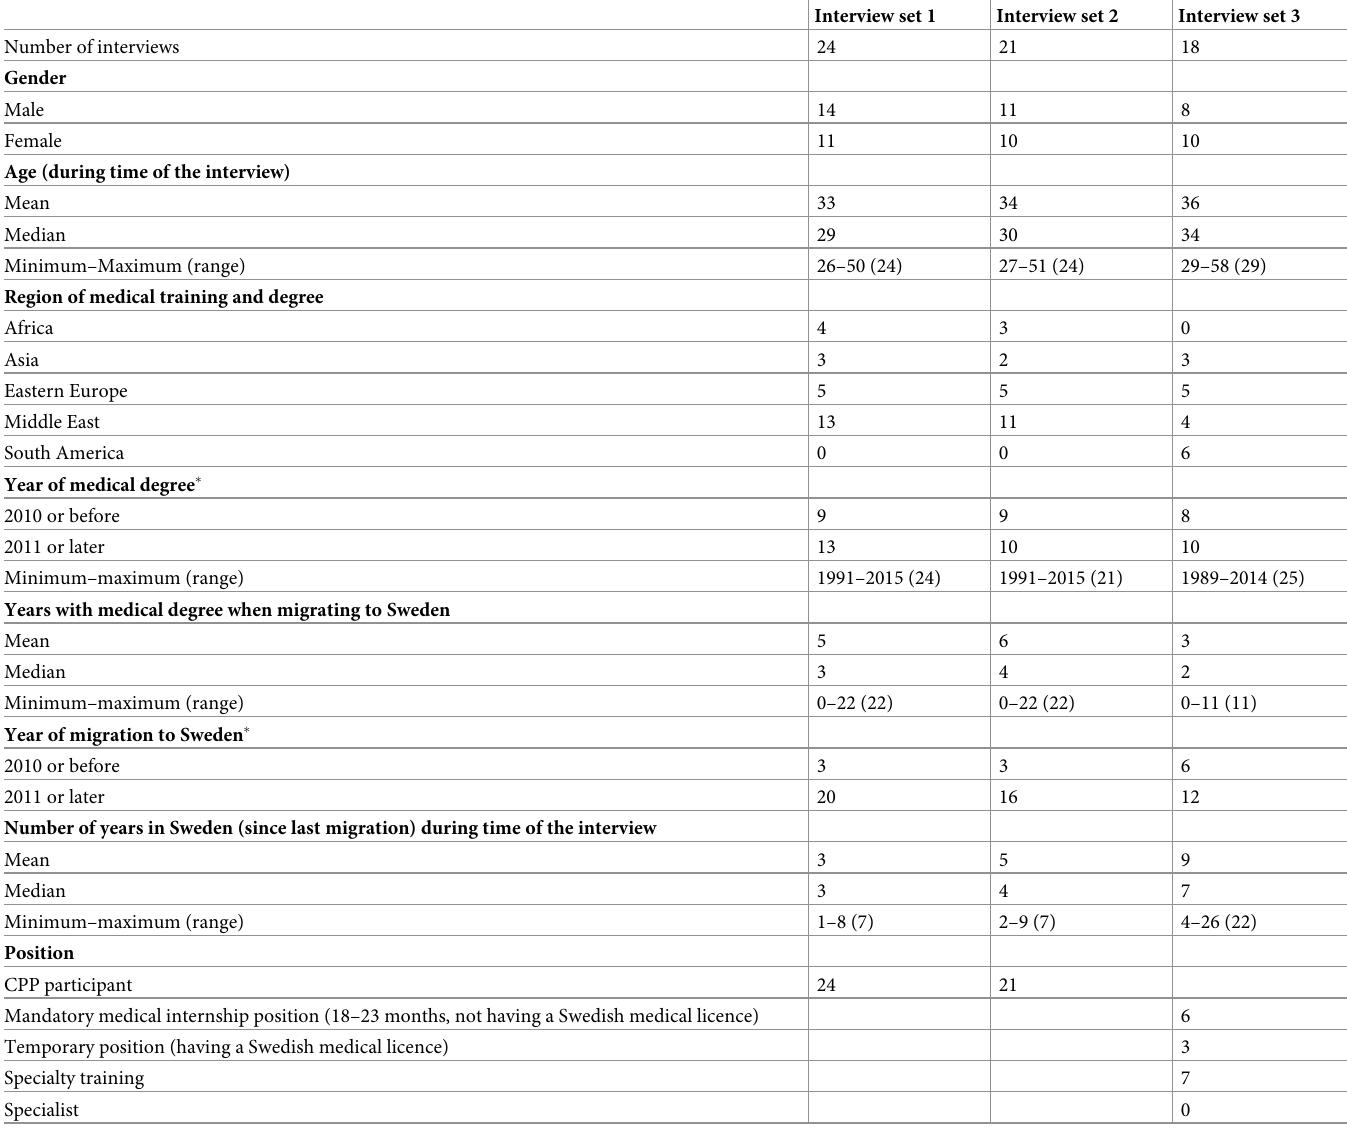
Table 2. The interviewed migrant physicians’